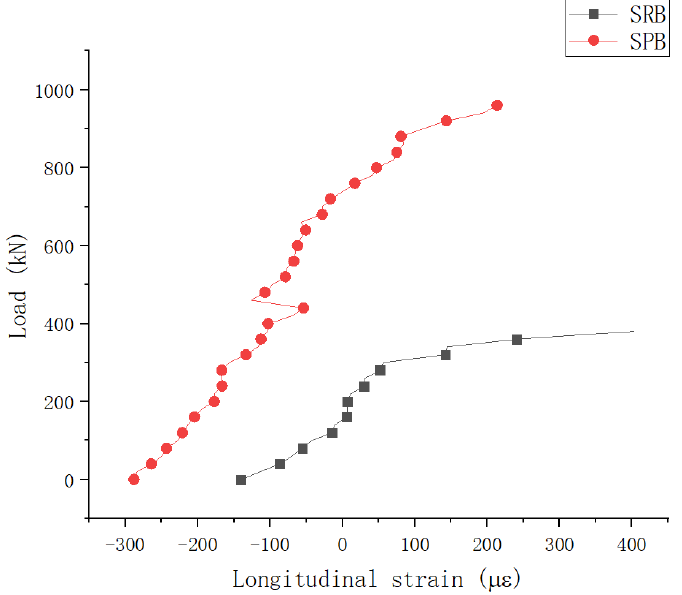
Figure 14. Load-Strain Curve of the Concrete Top Surface at the Middle Fulcrum Section.